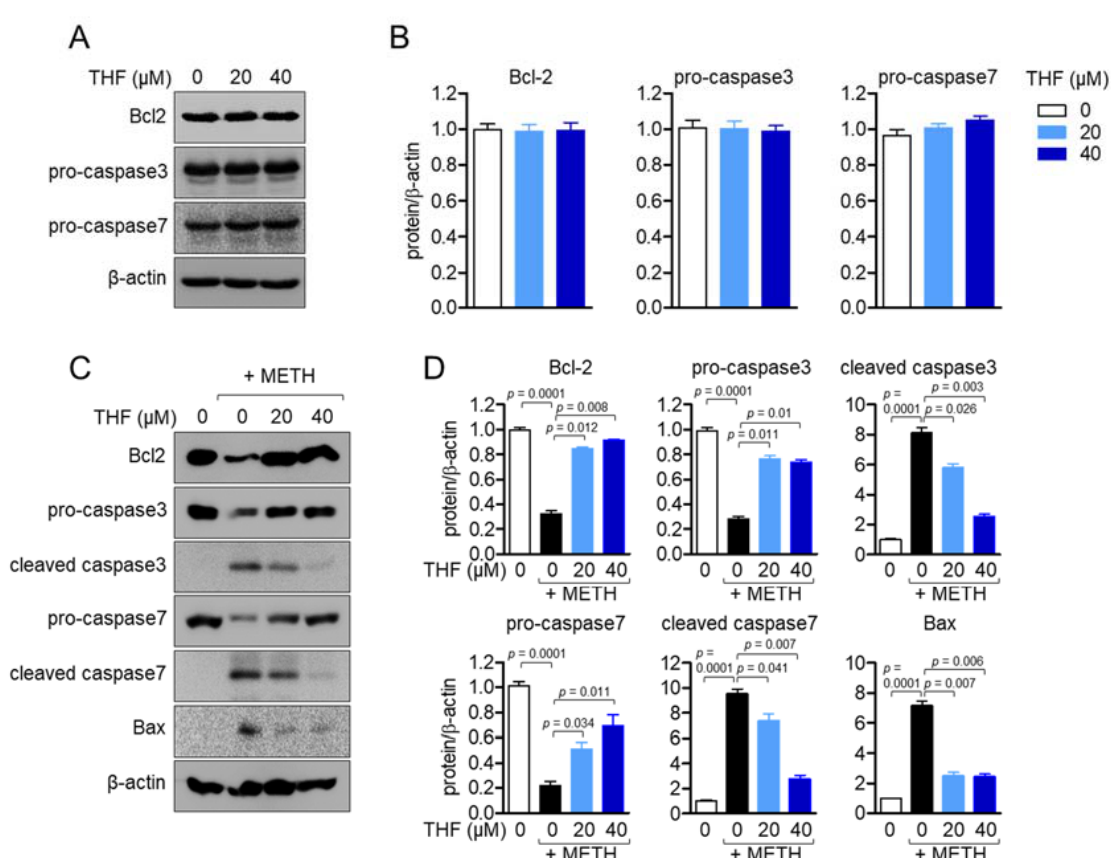
Figure 3. ( A ) SH-SY5y cells were treated with the indicated concentration of THF for 24 h and the expressions of the indicated proteins were detected by western blot. ( B ) The indicated proteins were normalized with the level of β -actin and presented in a bar graph. ( C ) SH-SY5y cells were pretreated with the indicated concentration of THF for 6 h and then exposed to 2 mM METH for an additional 24 h. The expression of apoptosis-related proteins was detected using western blot analysis. ( D ) The indicated proteins were normalized with the level of β -actin and presented in a bar graph. Results are shown as the mean value of three experiments ± SEM. p value between two indicated groups.